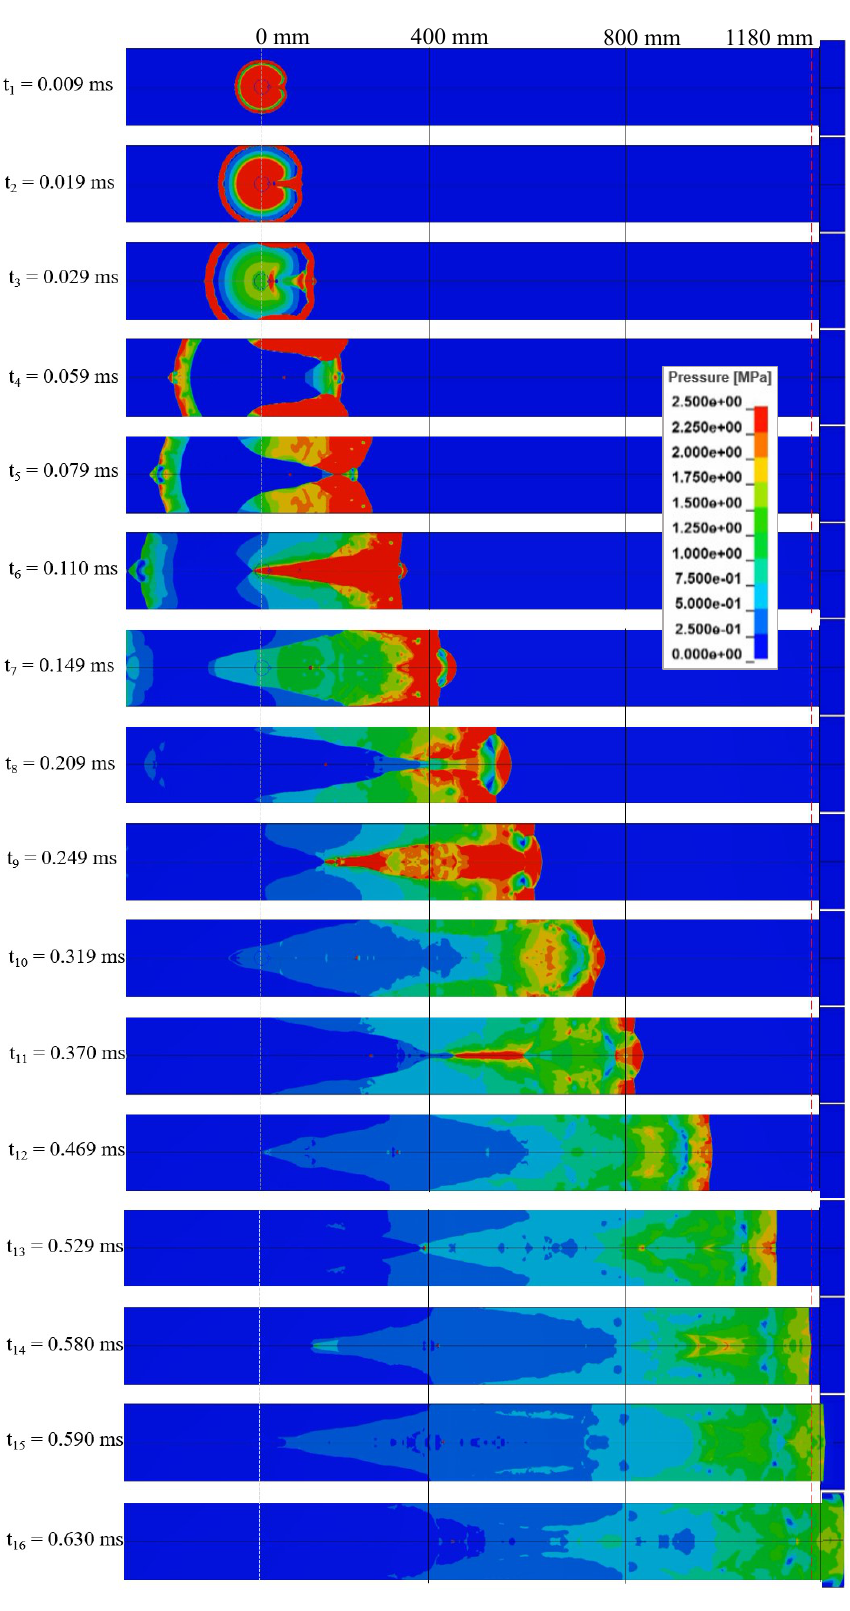
Figure 16. Propagation of a blast wave in the EDST (30 g C4 and 7 mm diameter projectile) (NB: the planarity of the blast wave front is checked via placing a section of tracers at 400 mm, 800 mm, 1180 mm, and 1200 mm from the detonation